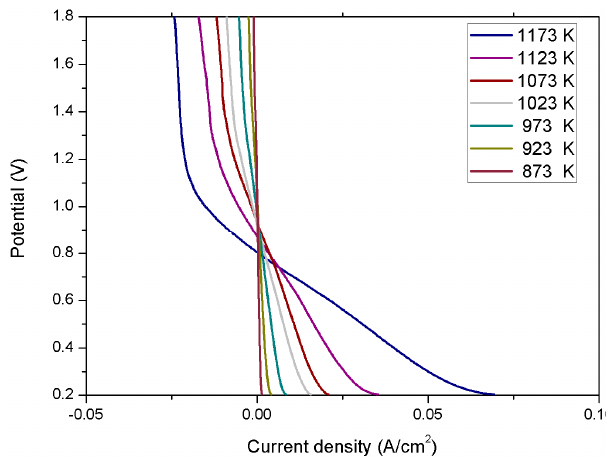
Figure 7 . The I / V curves of the SCGZ with 0 . 5 wt% CuO electrolyte - supported SOEC conducted from Figure 7. The I / V curves of the SCGZ with 0.5 wt% CuO electrolyte-supported SOEC conducted from 873 K to 1173 K under a constant steam to hydrogen ratio ( 70 : 30 ). 873 K to 1173 K under a constant steam to hydrogen ratio